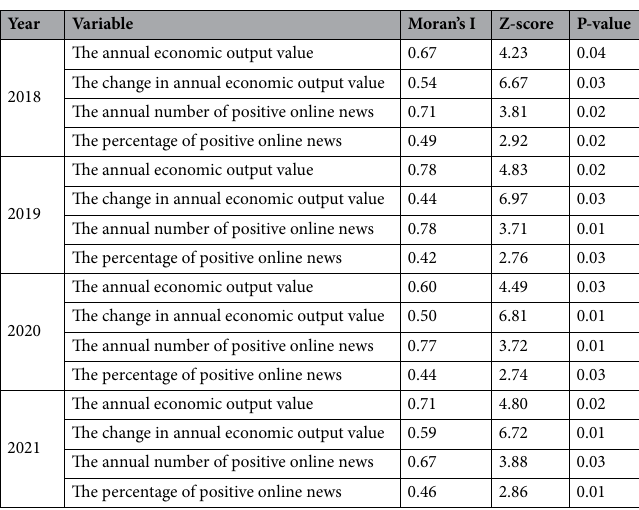
Table 2. Moran’s I statistical results for spatio-temporal cluster analysis.